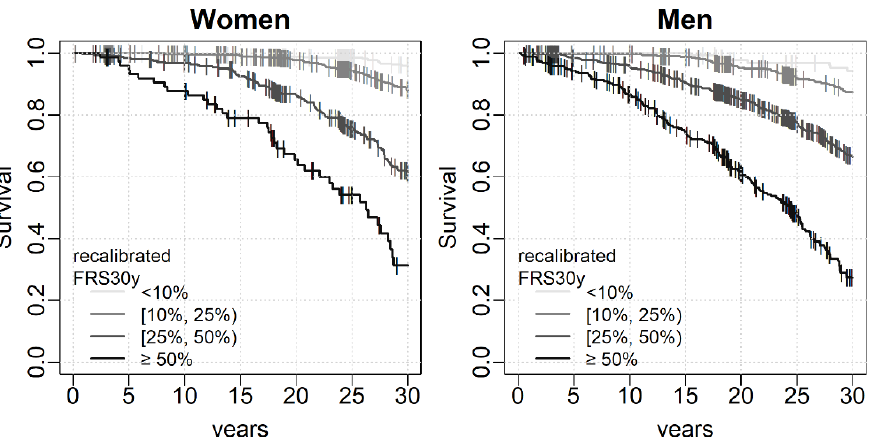
Figure 2. Survival (time free of fatal or non-fatal CVD event) in different risk strata. Shown are Kaplan-Meier curves for risk groups defined by different thresholds (10%, 25%, 50%) of the recalibrated FRS30y. Censored events (competing events or drop-out) are marked by vertical lines.